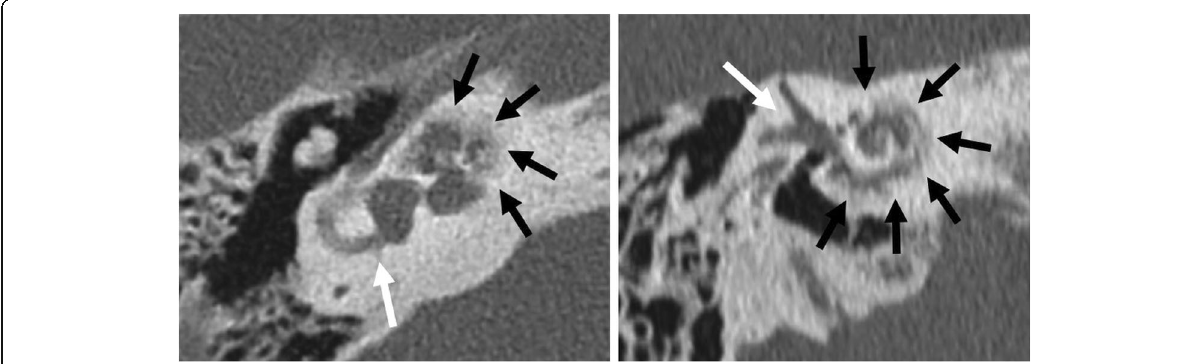
Fig. 16 A 70-year-old male patient, with progressive SNHL from advanced otosclerosis. HRCT axial (left image) and paracoronal (right image) image show irregular ossifications affecting the cochlea (black arrows). Vestibulum and semicircular canals (white arrows) are not